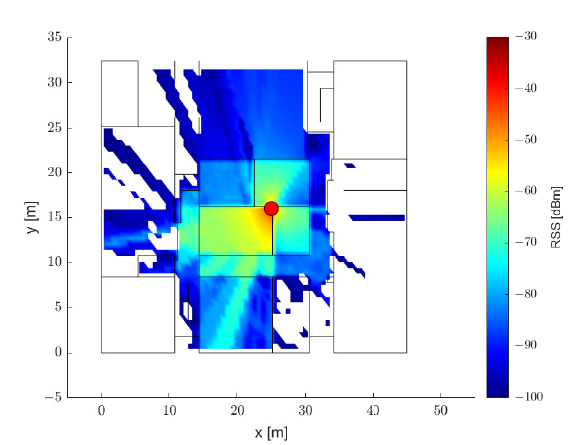
Figure 7. RSS map for an AP in the 5.2 GHz